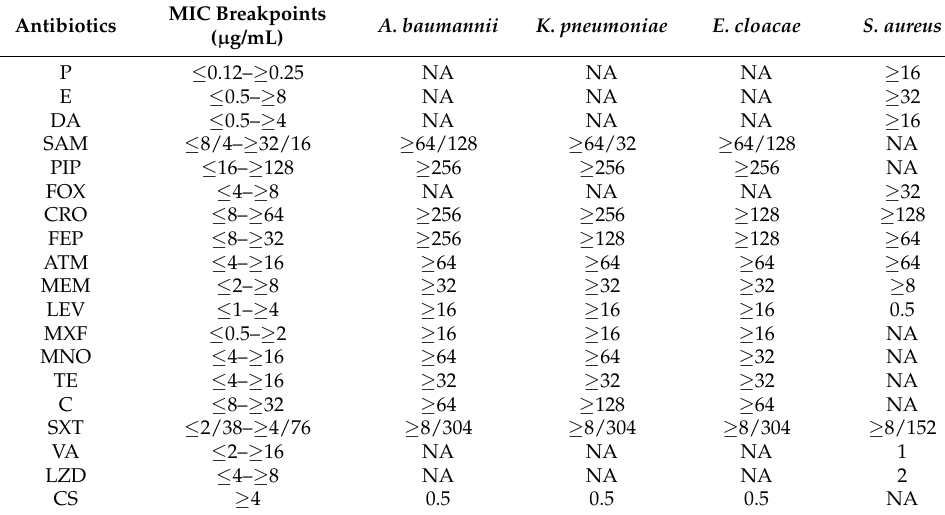
Table 3. MIC ( µ g/mL) of antibiotics against XDR pathogens.